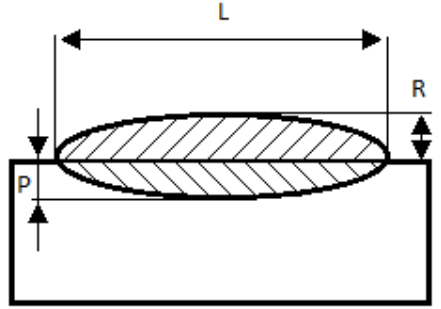
Figure 1. Geometric parameters analyzed in the welding bead.